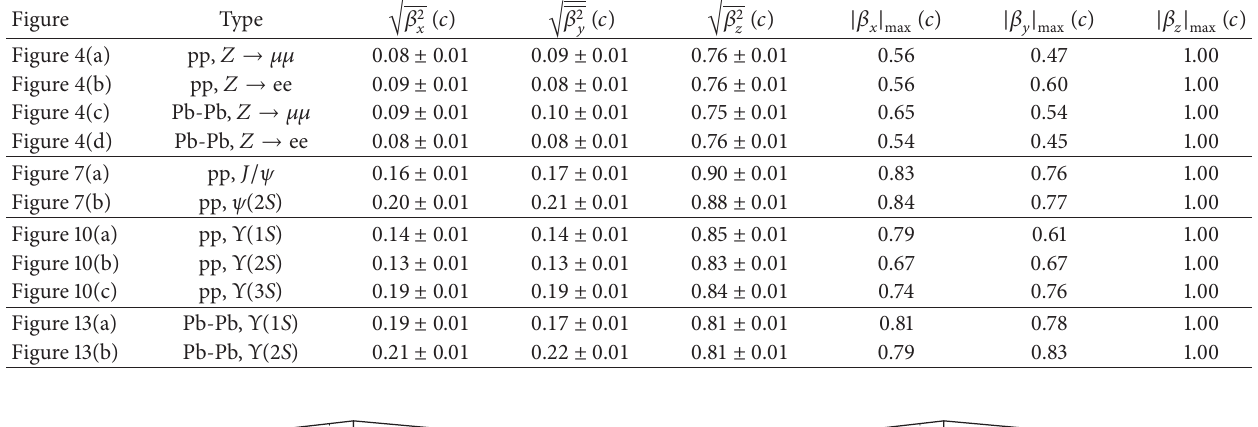
Table 4: Values of the root-mean-squares √𝛽 2 𝑥 for 𝛽 𝑥 , √𝛽 2 𝑦 for 𝛽 𝑦 , and √𝛽 2 𝑧 for 𝛽 𝑧 , as well as the maximum |𝛽 𝑥 | , |𝛽 𝑦 | , and |𝛽 𝑧 | ( |𝛽 𝑥 | max , |𝛽 𝑦 | max , and |𝛽 𝑧 | max ) corresponding to the particle scatter plots in Figures 4, 7, 10, and 13.